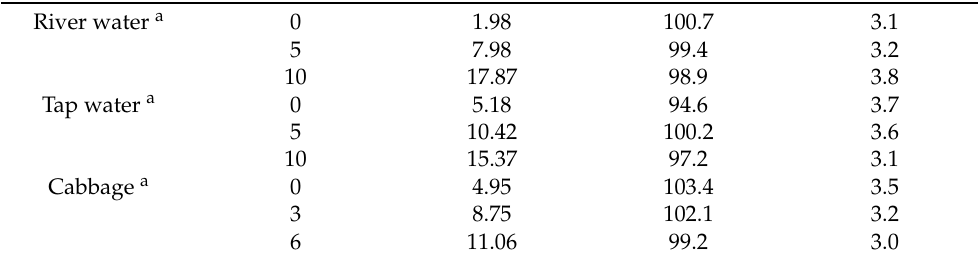
Table 2. Analytical results of Fe 3+ in real samples using 2-APC as a